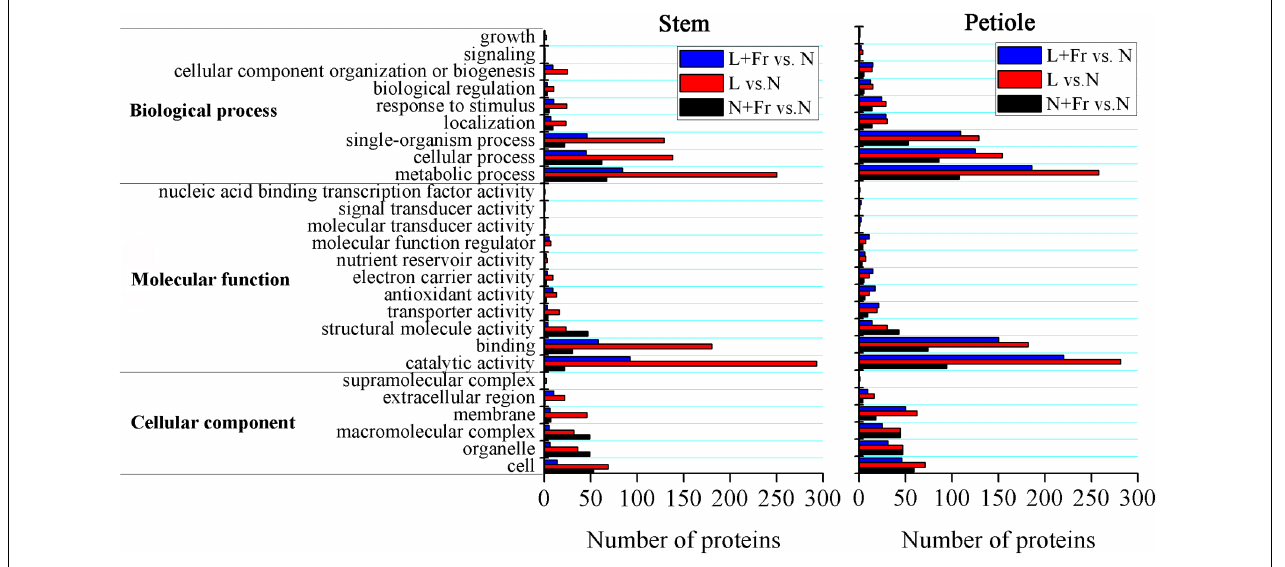
FIGURE 7 | Differential protein expression analyses of soybean stem and petiole in different treatments. N, N+Fr, L, and L+Fr denote normal light (normal PAR and normal R/Fr ratio), normal light plus far-red light (normal PAR and low R/Fr ratio), low light (low PAR and normal R/Fr ratio), and low light plus far-red light (low PAR and low R/Fr ratio), respectively.